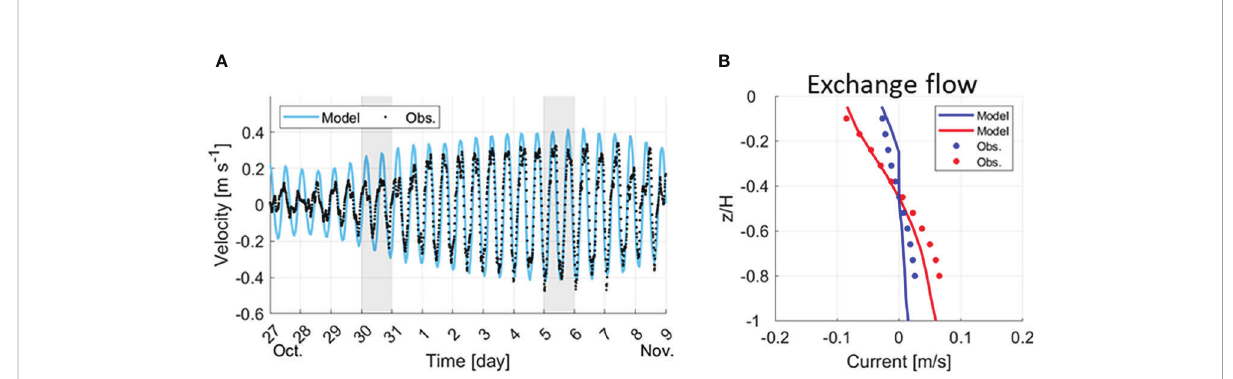
FIGURE 4 Comparison of fl ow rates between observations and the idealized model. (A) Time series of the depth-averaged velocity in observations (black dots) and the model (cyan line), with grey shading indicating Conductivity – Temperature – Depth (CTD) observation dates. (B) Vertical velocity pro fi le of the observations (dots) and model (lines) during spring (red) and neap (blue) tides denoted by CTD observation data (grey shading boxes) in (A)